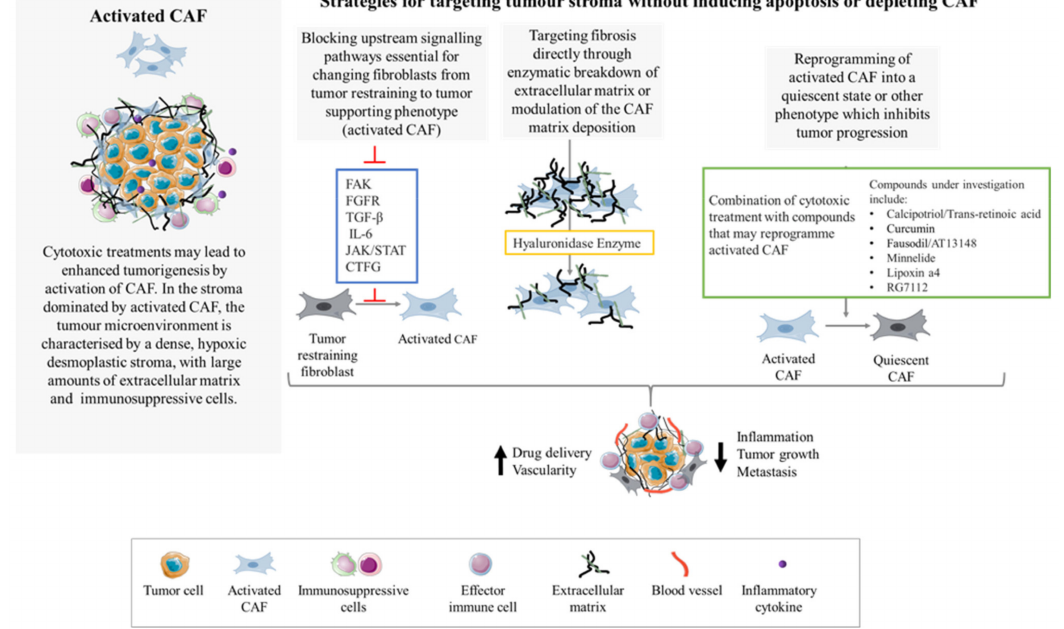
Figure 3. Targeting CAF without ablation or apoptosis induction. Activated CAF fuel desmoplasia, fibrosis, inflammation and tumor growth. To prevent or suppress the activation and formation of the desmoplastic reaction, strategies such as targeting upstream signaling pathways for CAF activation or reprogramming of activated CAF into a quiescent phenotype have been trialed. Another strategy is to target fibrosis directly with enzymatic breakdown of the